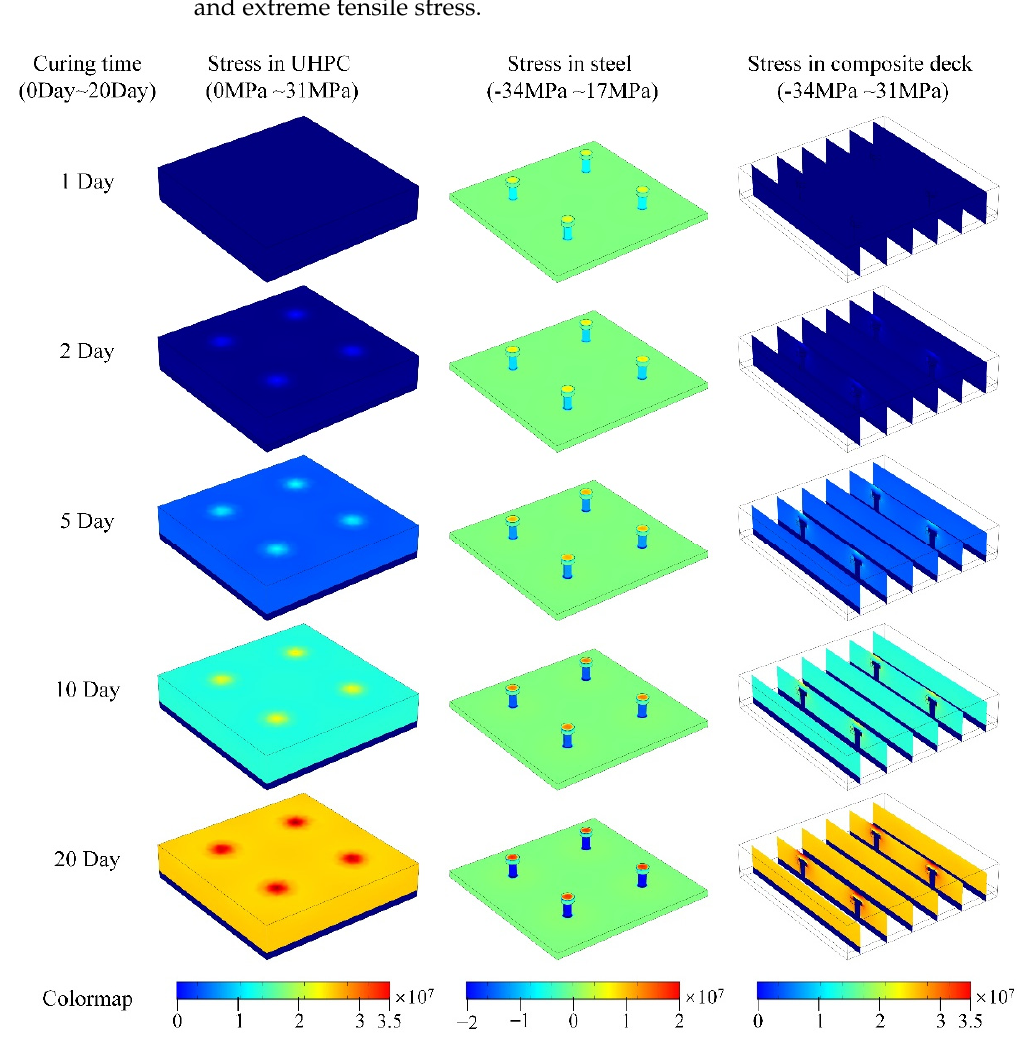
Figure 8. The stress distribution in the UHPC layer, the steel stud connectors, and the model slices in the composite’s deck. Table 4. Stress value in UHPC and steel during shrinkage process.